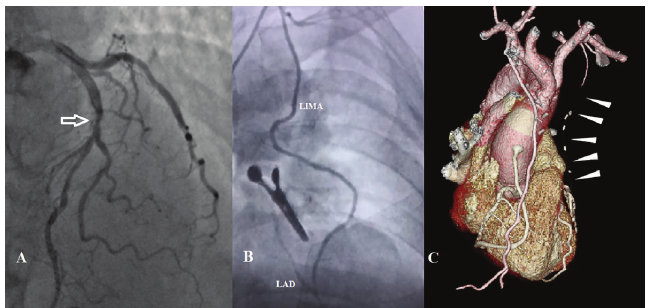
Figure 3 - 65-year old female with three-vessel disease. Coronary angiography before coronary artery bypass grafting. Proximal LAD had 75% stenoses angiographically and the iFR was 0.92 (A, white arrow). Selective intraoperative angiography demonstrated attached LIMA graft patency (B). CTA showed that the LIMA to LAD graft had failed (C, white